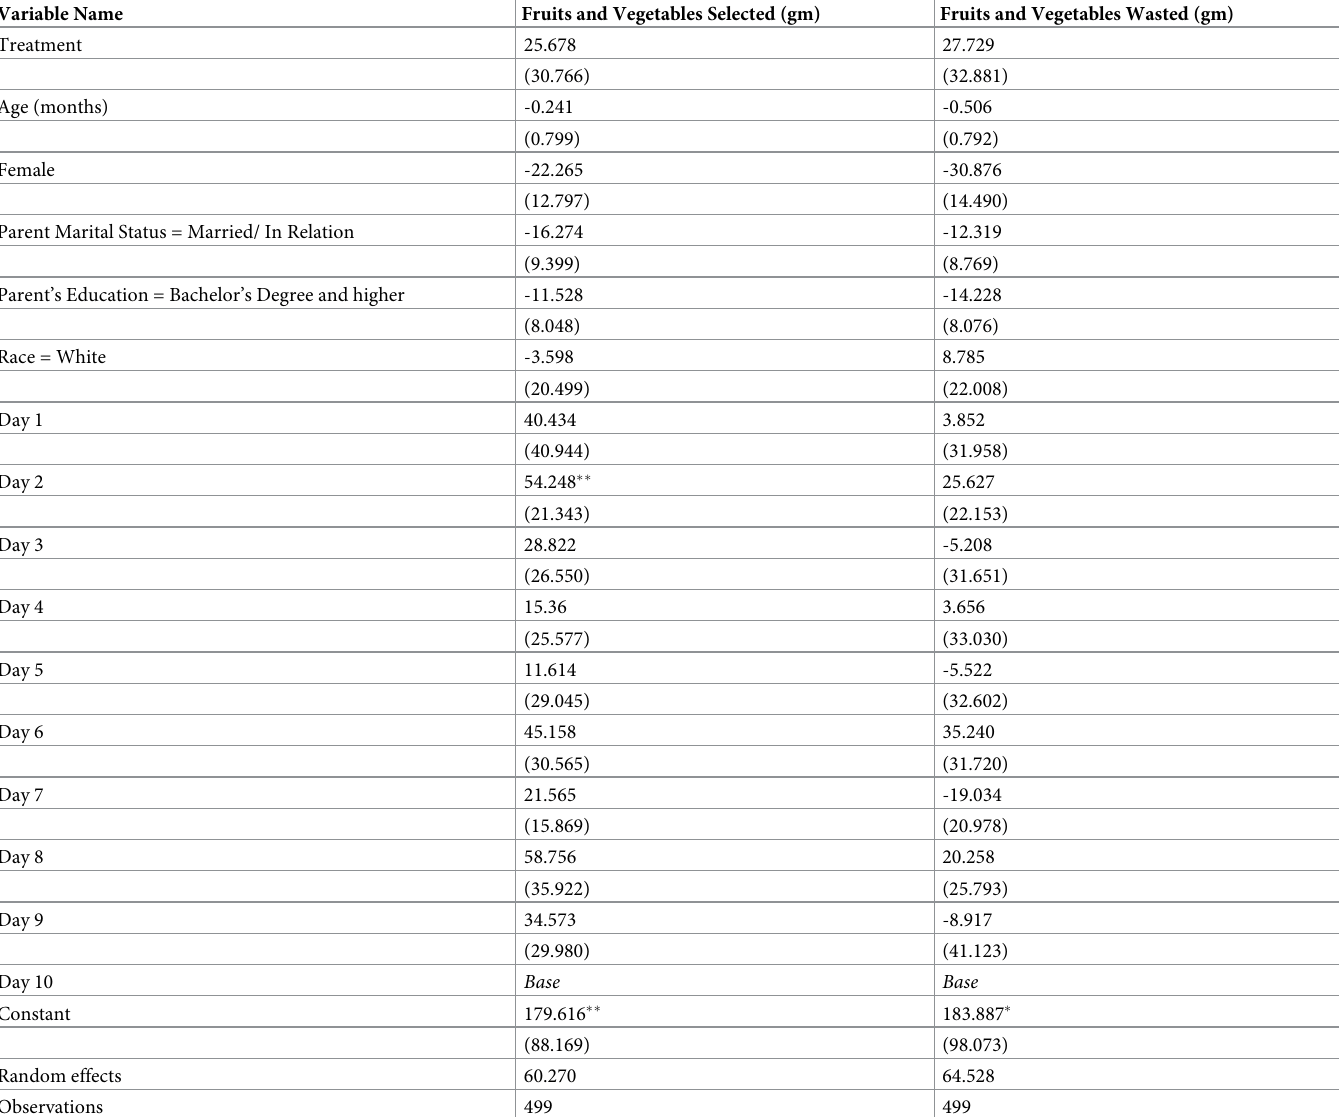
Table 5. Impact of nutrition education intervention on the amount of fruits and vegetables selected and